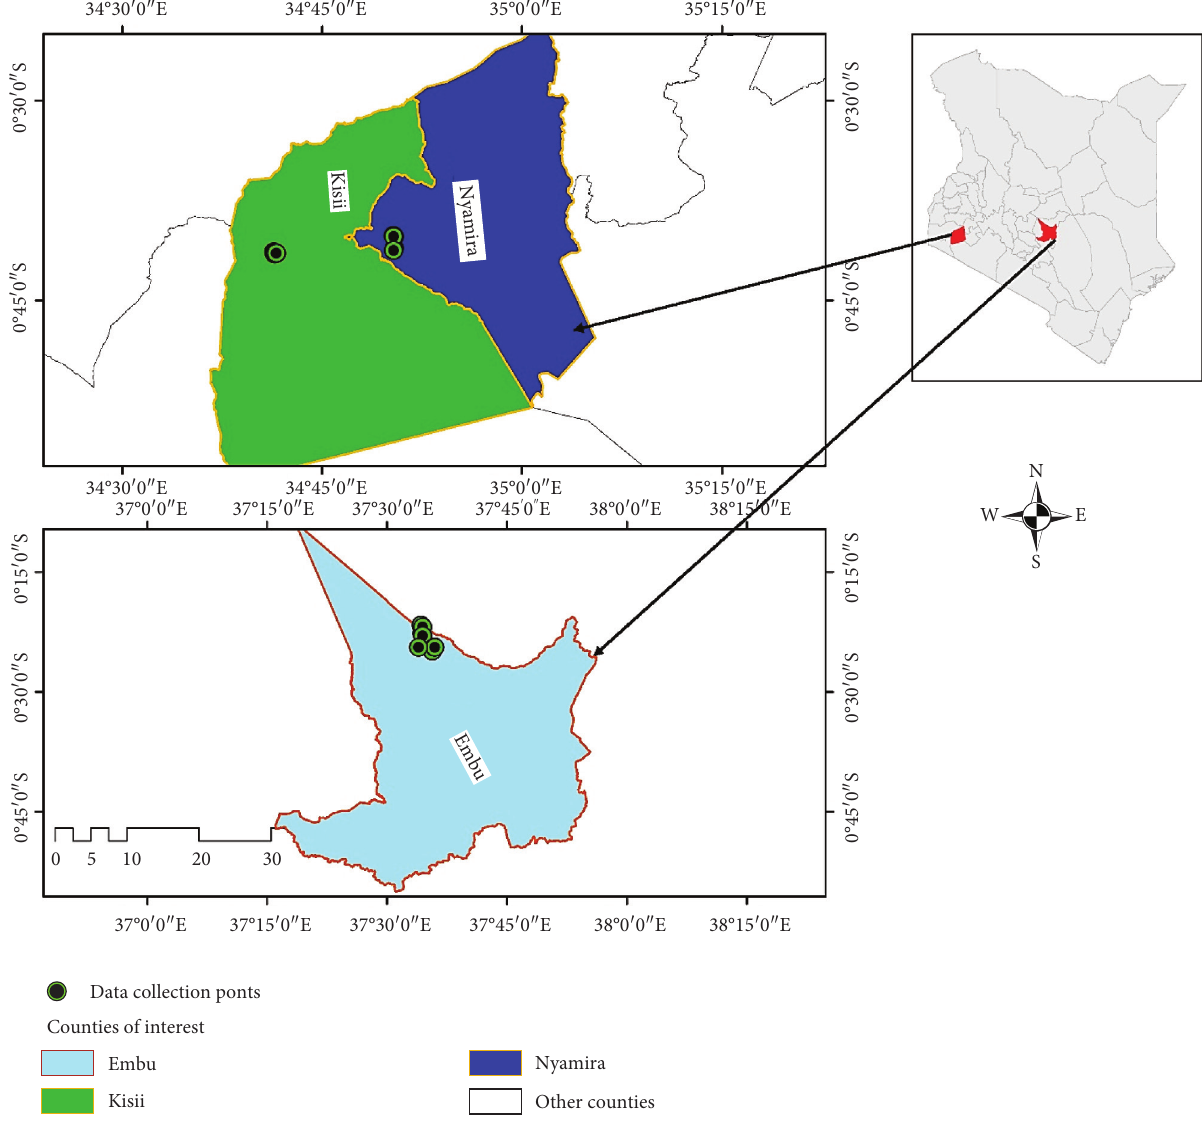
Figure 1: Map of study regions in Kisii, Nyamira, and Embu counties generated from GPS